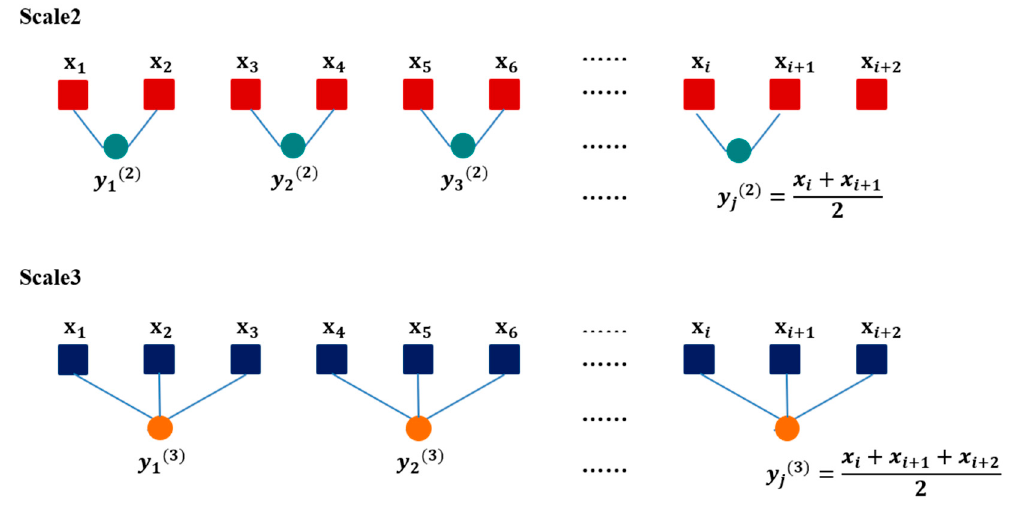
Figure 2. Schematic of Phase 2 (sample entropy) of the multiscale entropy (MSE) analysis.